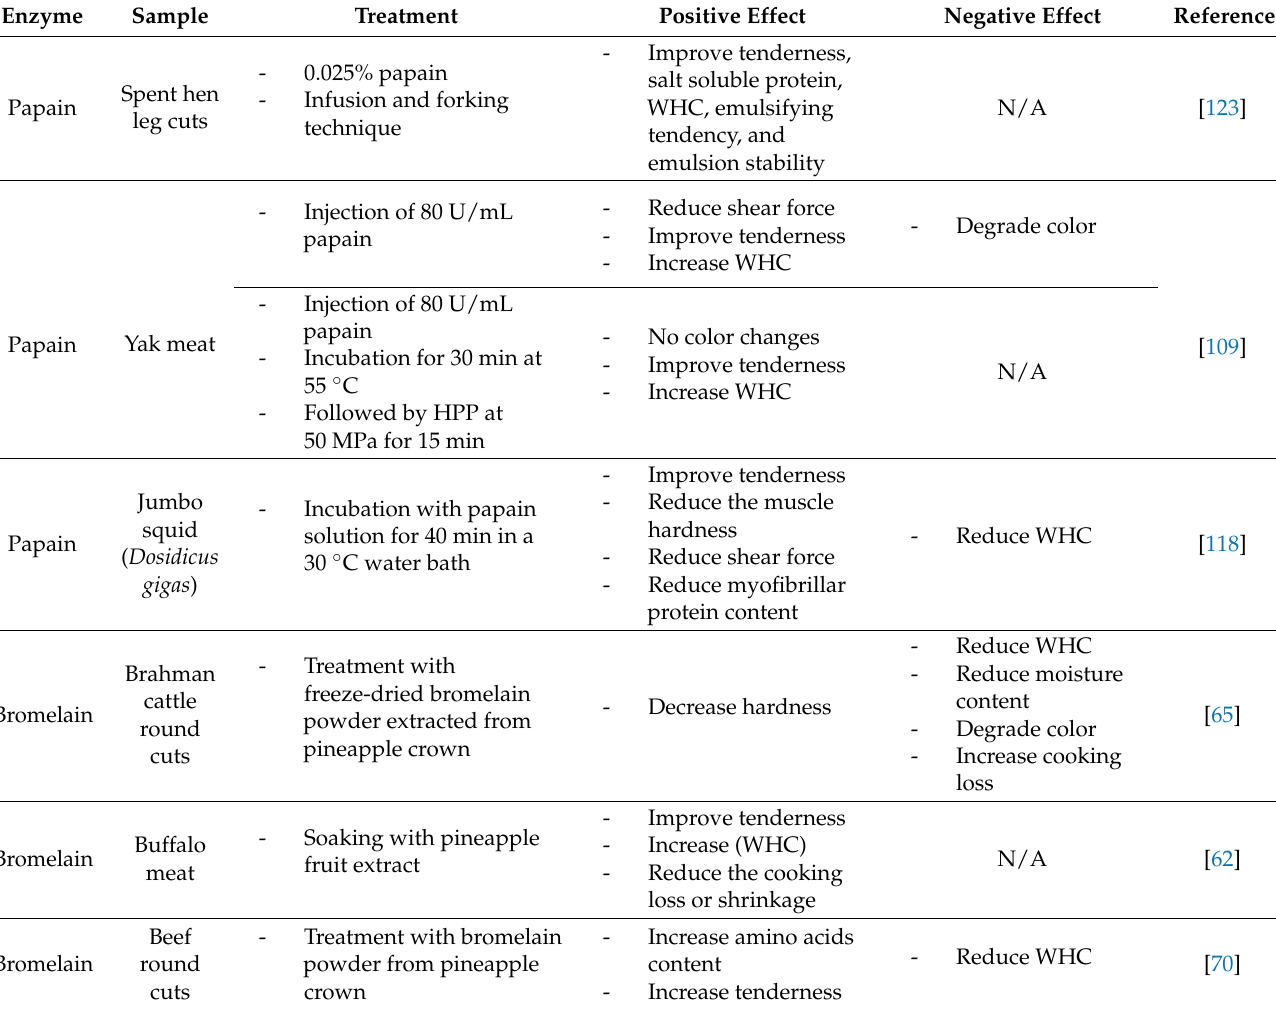
Table 2. Application of plant proteases in meat